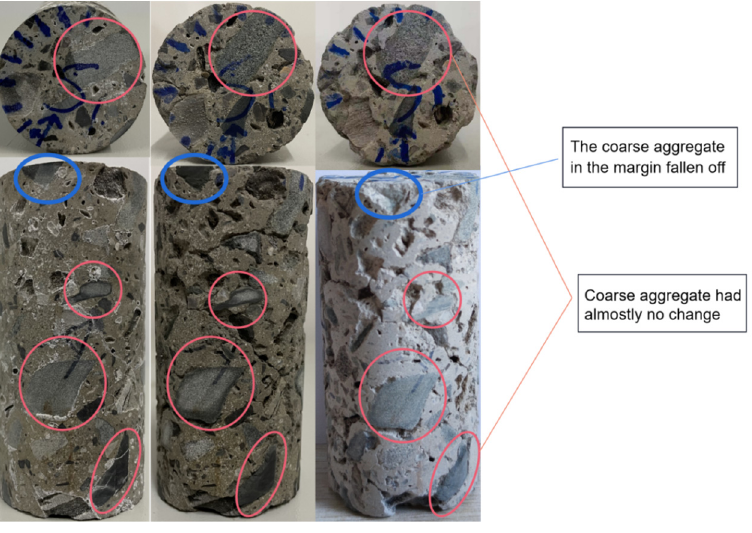
Figure 11. Appearance changes of the concrete specimen.